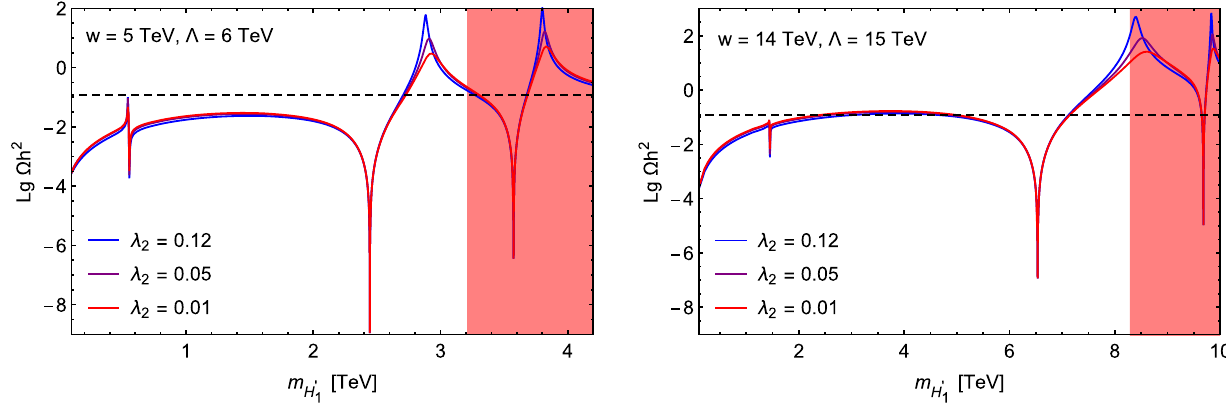
Fig. 2 The relic density of the scalar candidate as a function of the DM mass according to the several choices of w,(cid:11) , where the DM unstable region (light red) is the band on the right side of each